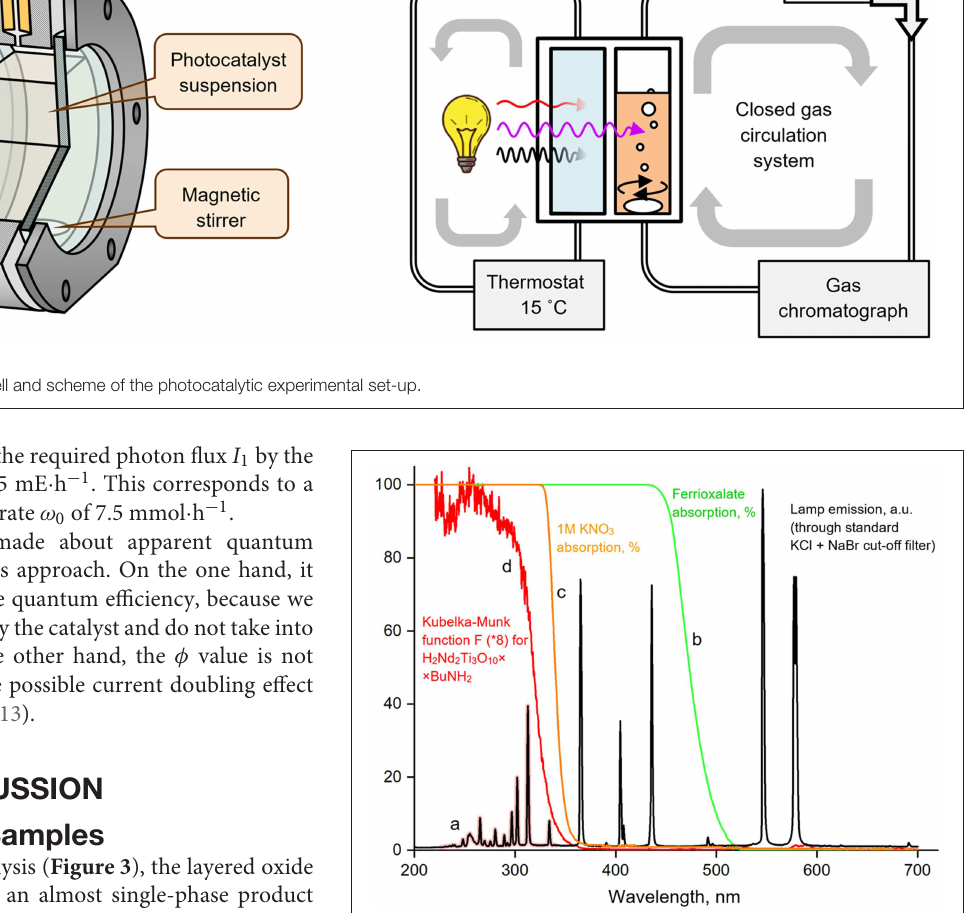
The treatment of the H 2 Nd 2 Ti 3 O 10 sample with methylamine